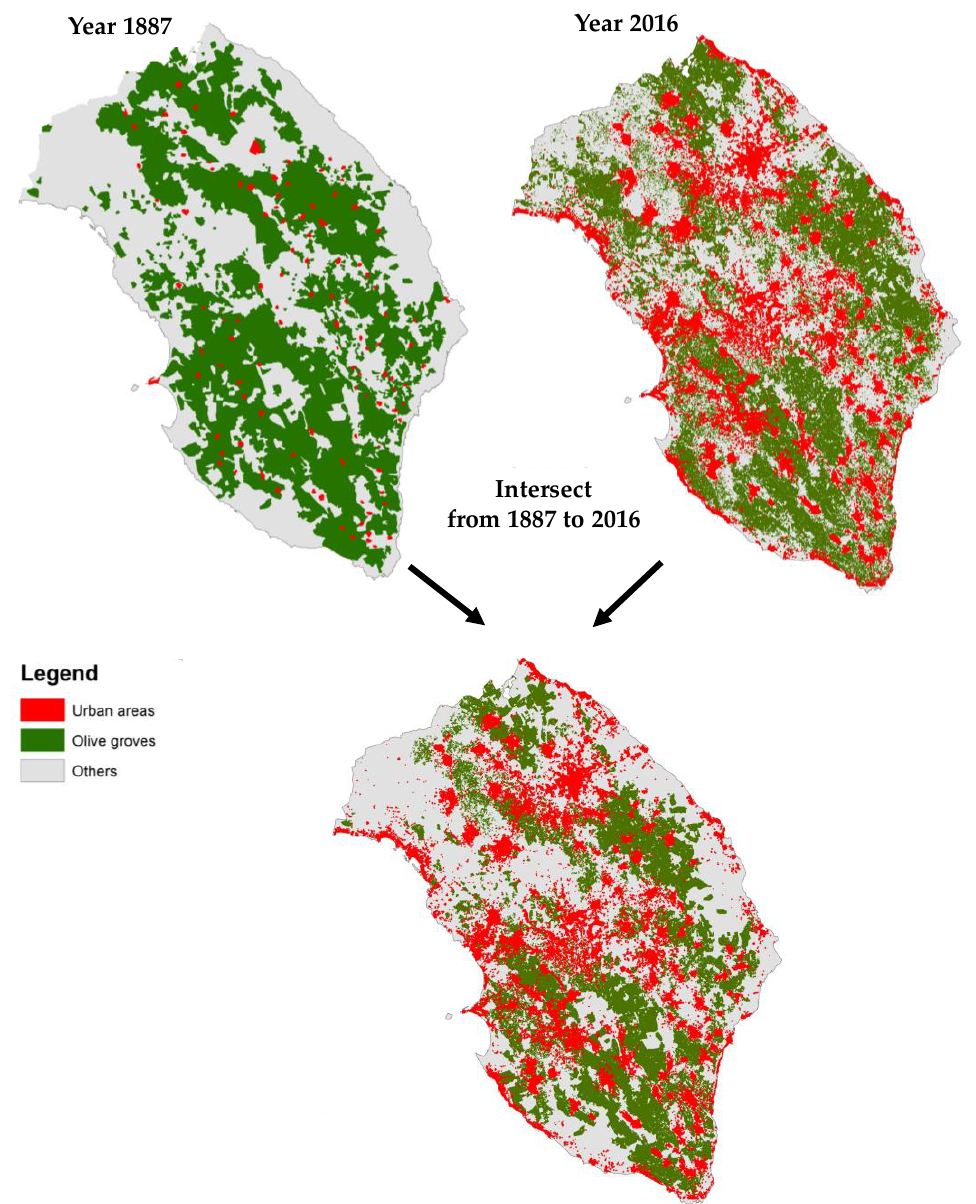
Figure 4. Maps showing the presence of urban areas, olive groves and other land uses in the years 1887 and 2016 and relative intersection.